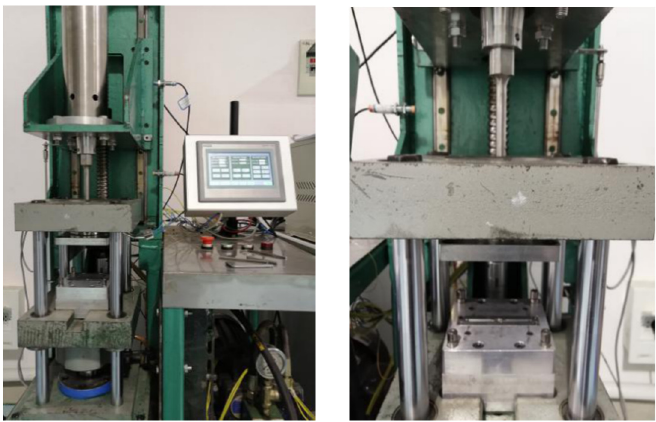
Figure 1. Prototype machine for ultrasonic plasticization. Table 2. Main characteristics of prototype machine.